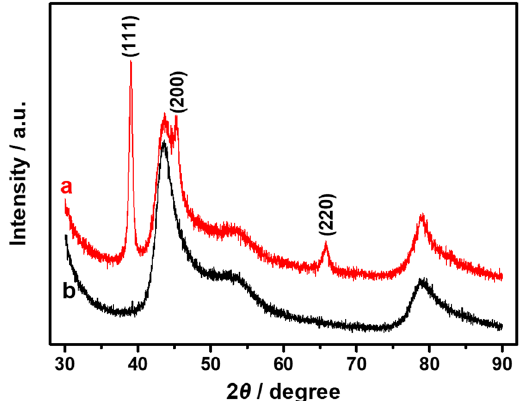
Figure 5. XRD patterns of the as-prepared AuPt NFs (curve a) and bare GCE (curve b).